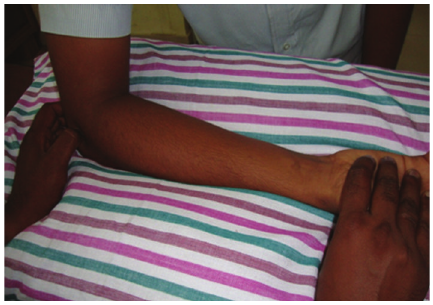
Figure 1: Deep transverse friction massage.